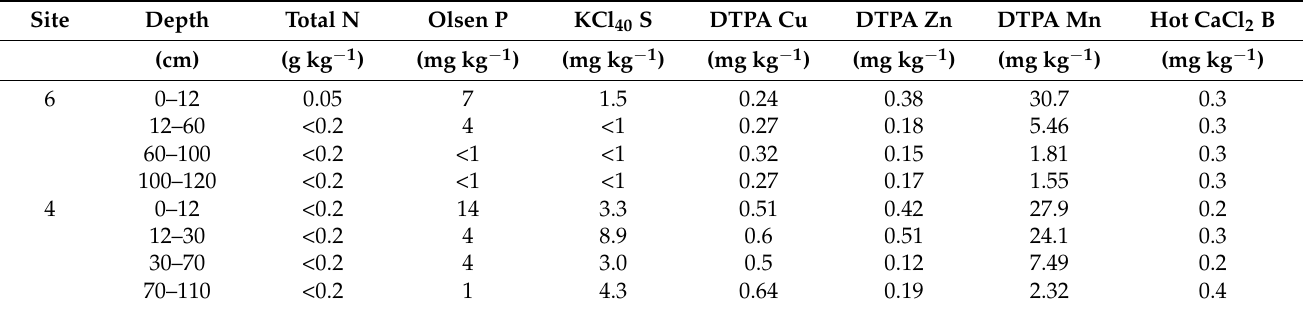
Table 5. Soil chemical properties of two profiles from Tramkak District, Takeo Province, Cambodia, classified as sandy soils. Profiles were classified as Site 6, Prey Khmer Soil Group, fine sandy phase, and Site 4 Prateah Lang Soil, loamy subsoil phase